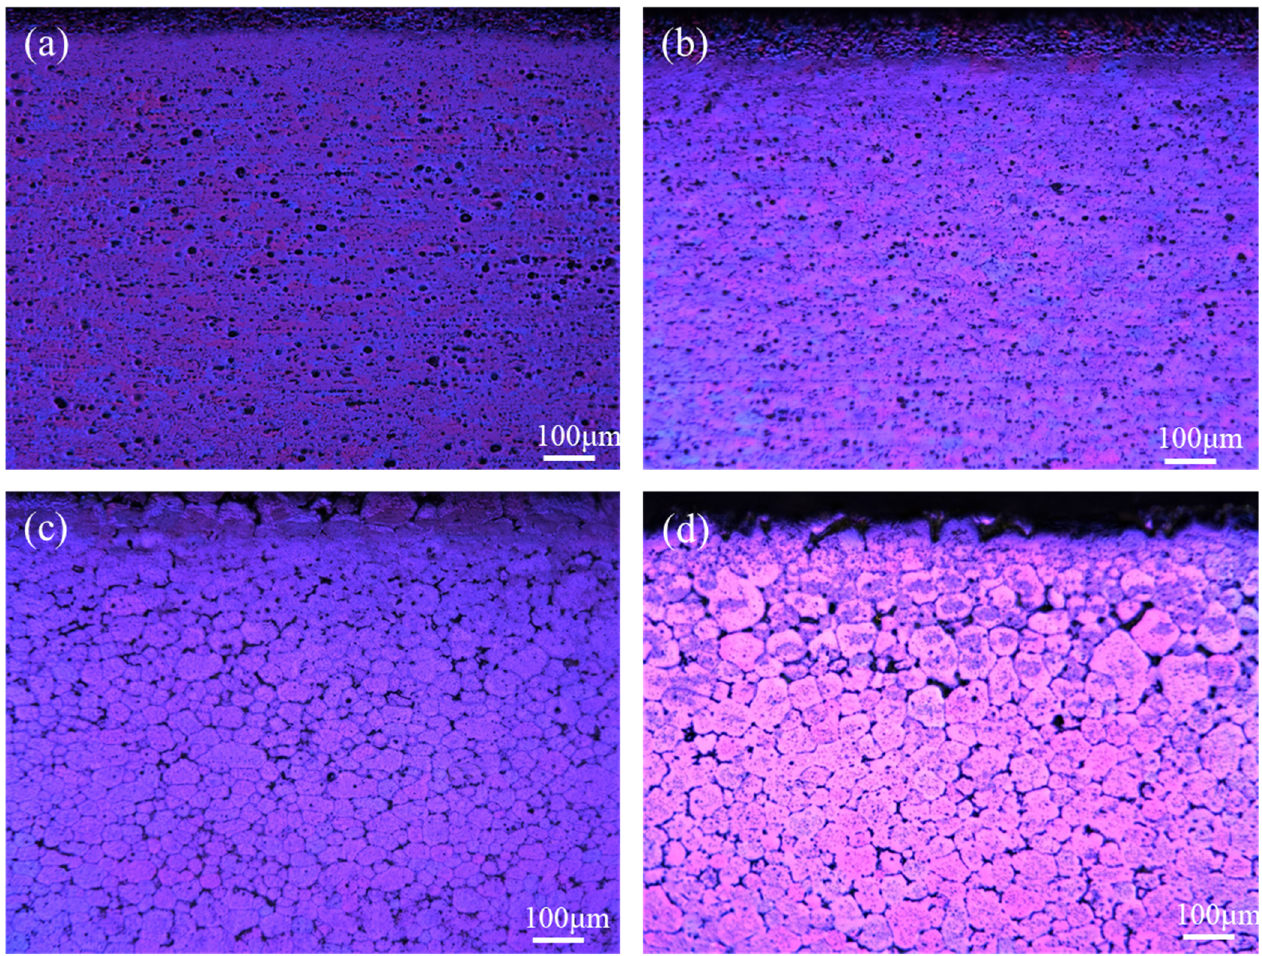
Figure 6. Microstructures of 4343/3003/6111/3003 Al clad sheet under various conditions: ( a ) cold-rolled state; ( b ) 330 °C/3 h (annealed state); ( c ) 330 °C/3 h + 610 °C/10 min (brazed state); ( d ) ◦ C/3 h (annealed state); ( c ) 330 ◦ C/3 h + 610 ◦ C/10 min (brazed state); 330 °C/3 h + 610 °C/10 min + 180 °C/8 h (aged state). ( a ) cold-rolled state; ( b ) 330 ( d ) 330 ◦ C/3 h + 610 ◦ C/10 min + 180 ◦ C/8 h (aged